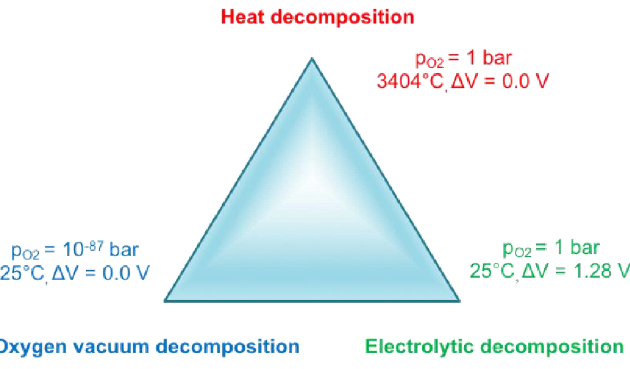
Figure 16. How to recover iron from oxides by pure physical means?